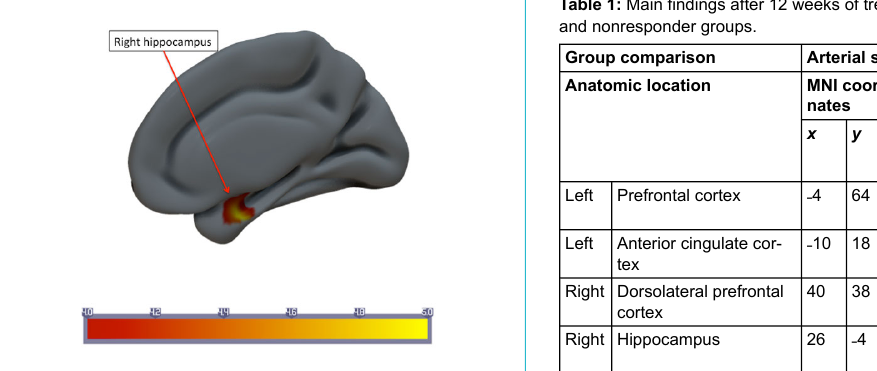
Figure 3: Statistical parametric map of longitudinal changes in mean cerebral blood flow (CBF) in the nonresponder group. Up- regulation of CBF in the right hippocampus.